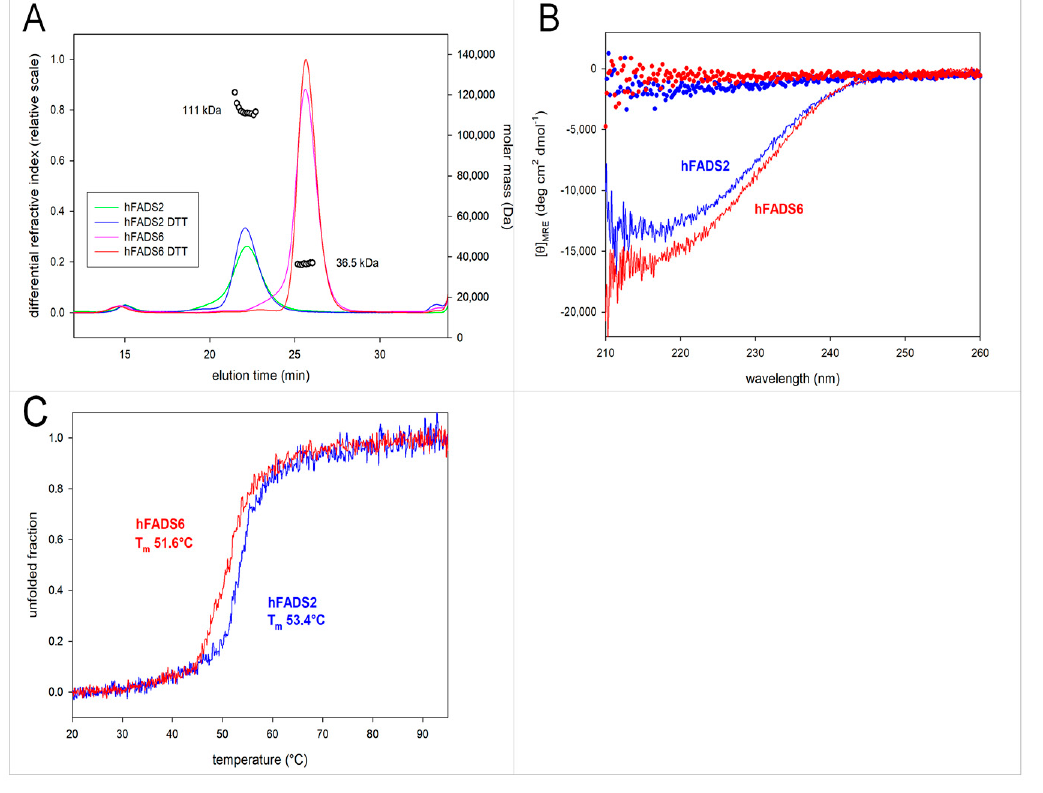
Figure 4. Characterization of the recombinant protein. ( A ) Tandem HPLC-GPC/LS profiles of 6-His-hFADS6 and 6-His-hFADS2. Proteins were separated on a Superose 12 column, connected in series to a dual wavelength detector, a refractive index detector, and a Dawn Heleos MALS system. The column was run in 40 mM Hepes/Na, 150 mM NaCl, pH 7.4, containing 1 mM DTT when indicated. Empty circles above individual protein peaks indicate the molecular mass calculated from MALS data; ( B ) Far-UV circular dichroism spectra of 6-His-hFADS6 and 6-His-hFADS2 in the absence (full lines) and in the presence (dotted lines) of 6 M urea. Spectra were recorded at 20 ◦ C in 1-mm path length cells, on 0.2 mg · mL − 1 protein solutions in 40 mM Hepes/Na, 150 mM NaCL, 1 mM DTT, pH 7.4; ( C ) Temperature ramp experiments were performed on 0.2 mg · mL − 1 protein solutions in 40 mM Hepes/Na, 150 mM NaCl, 1 mM DTT, pH 7.4 by increasing the temperature from 20 ◦ C to 95 ◦ C at a heating rate of 1 ◦ C min while continuously monitoring the loss of CD signal at 220 nm. Both FADS isoforms show a cooperative folding/unfolding transition. Data were processed to calculate the midpoint temperature (T m ) for the native/denatured transition (53.4 ◦ C for hFADS2 vs. 51.6 ◦ C for